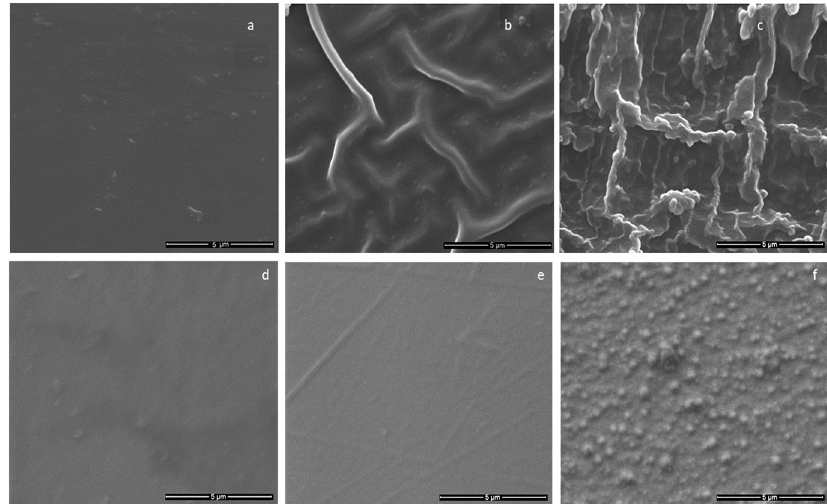
Figure 7. SEM images of: ( a ) 1 mm thickness polymer substrate; and CaP coatings generated on 1 mm thickness polymeric substrates at: ( b ) p = 1.2 × 10 − 2 mbarr; and ( c ) p = 4.6 × 10 − 3 mbarr; Ar gas working pressure; ( d ) 200 µ m thickness polymer substrates; and CaP coatings generated on 200 µ m polymeric substrates at: ( e ) p = 1.2 × 10 − 2 mbarr; and ( f ) p = 4.6 × 10 − 3 mbarr; Ar gas working pressure.